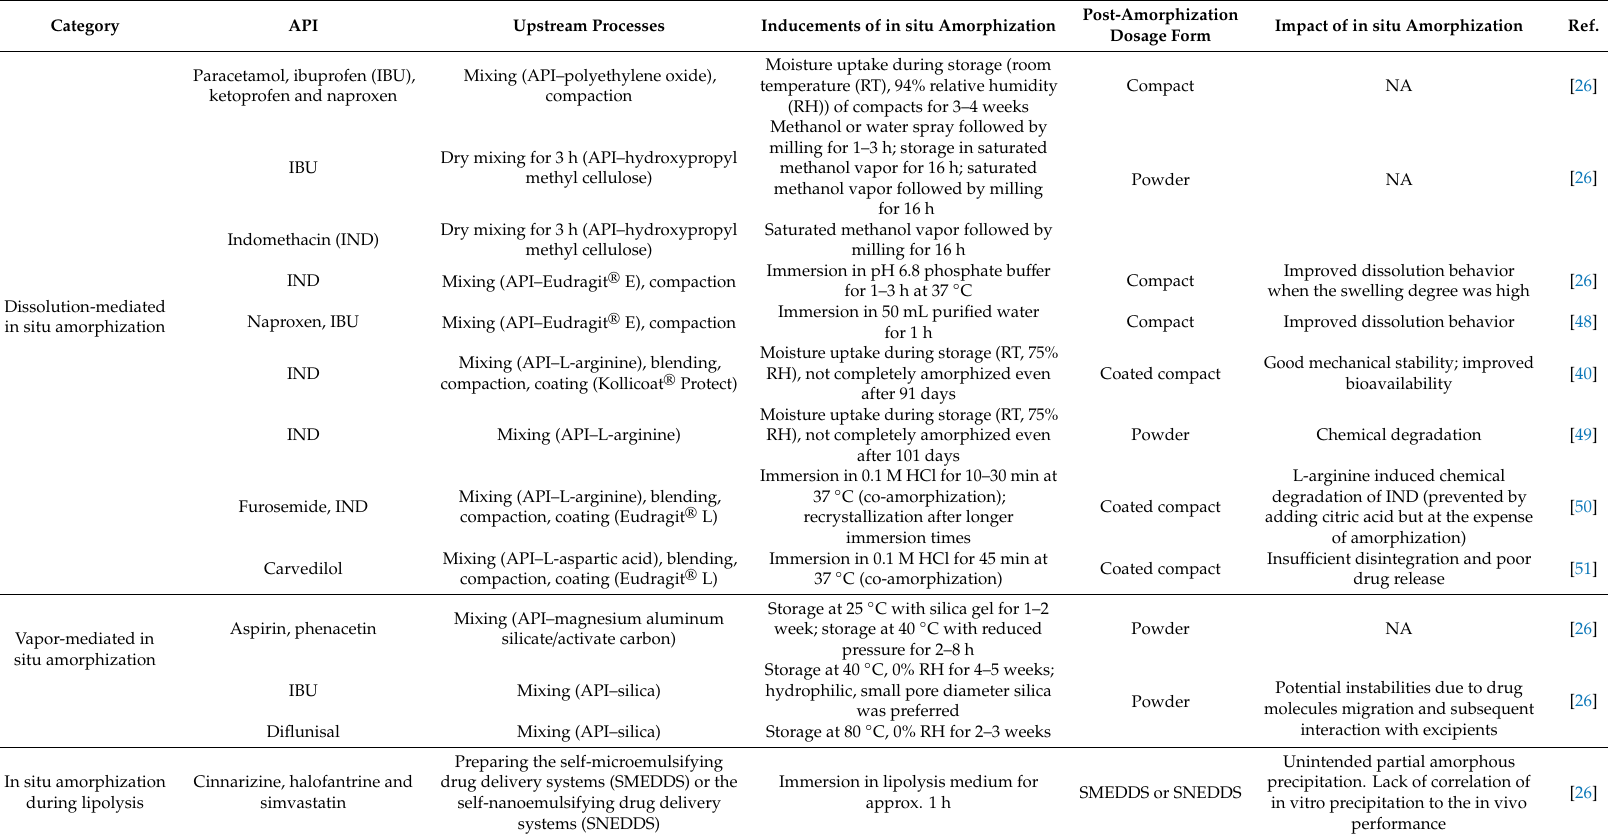
Table 1. The applications of non-microwave induced in situ amorphization in oral drug